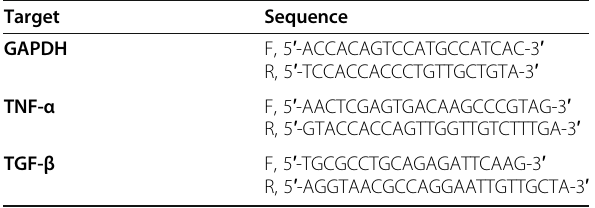
Table 1 Primer sequence of GAPDH, tumor necrosis